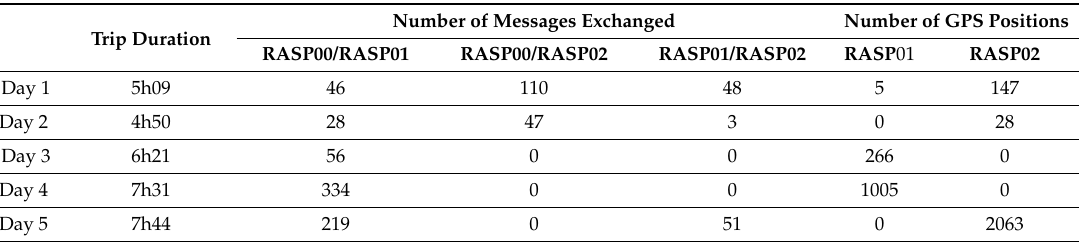
Table 1. Data of active days.